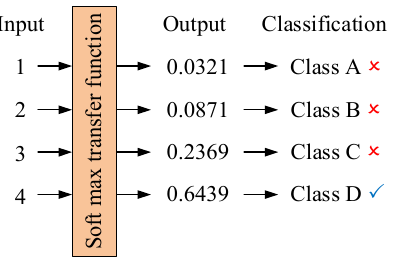
Figure 5. Schematic diagram of softmax.